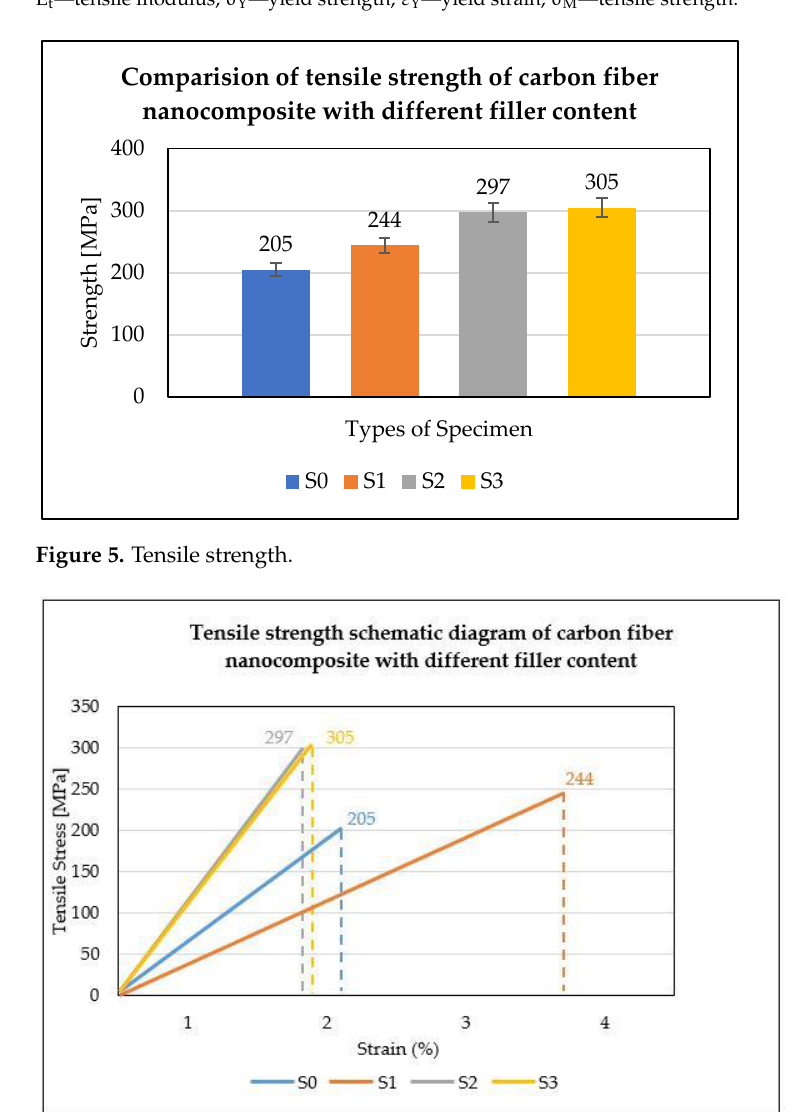
Figure 6. Stress vs. Strain schematic diagram.3.3. Impact Tests